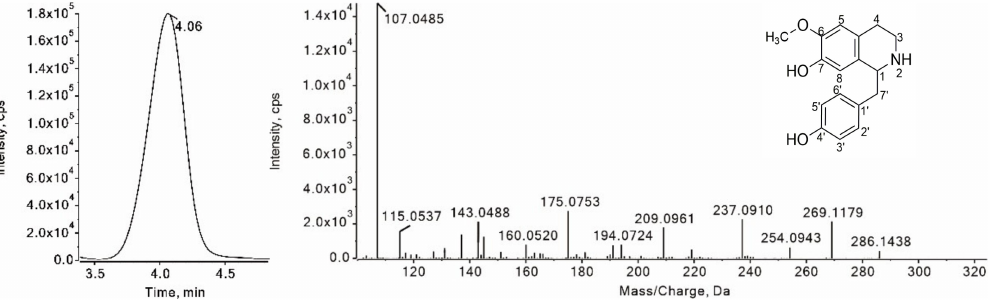
Figure 6. XIC and the MS/MS spectrum of